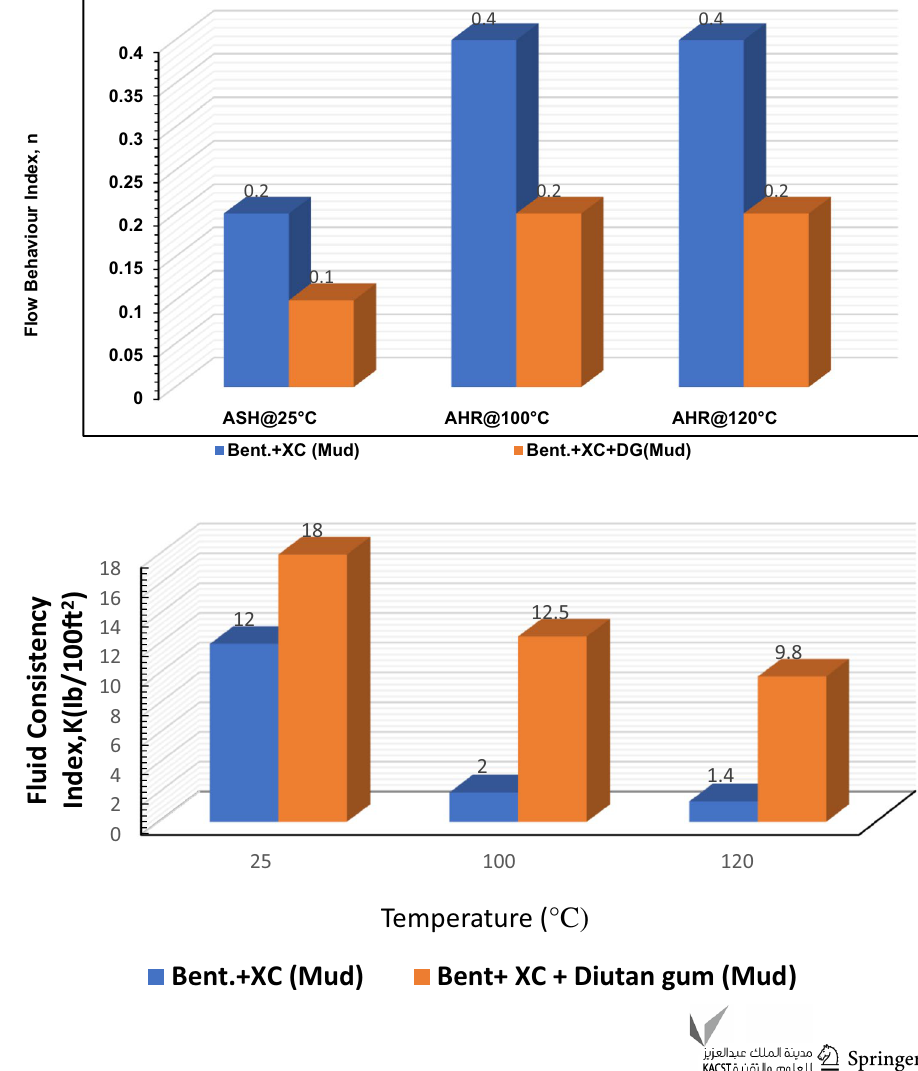
Fig. 5 Flow behavior index of the mud formulations